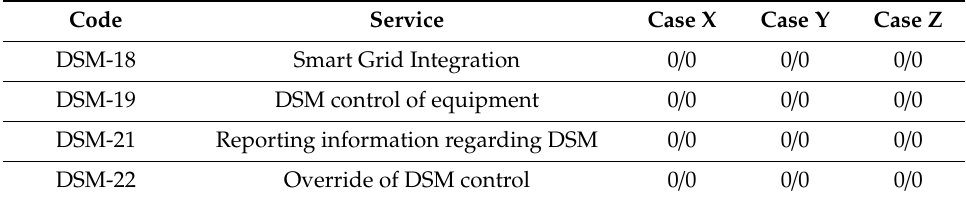
Table 10. The functionality levels in the main domain of demand side management (DSM).